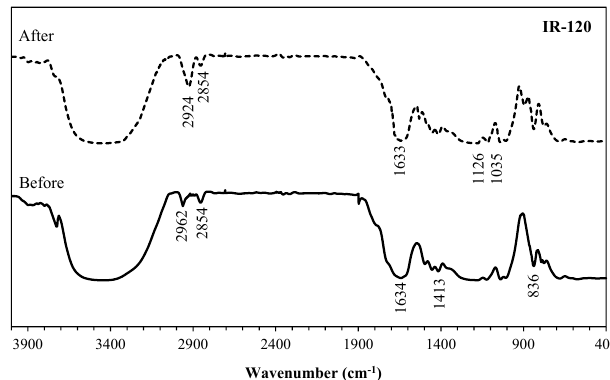
Fig. 6. FTIR spectra of the Amberlite IR-120 adsorbent before and after Th(IV) adsorption.